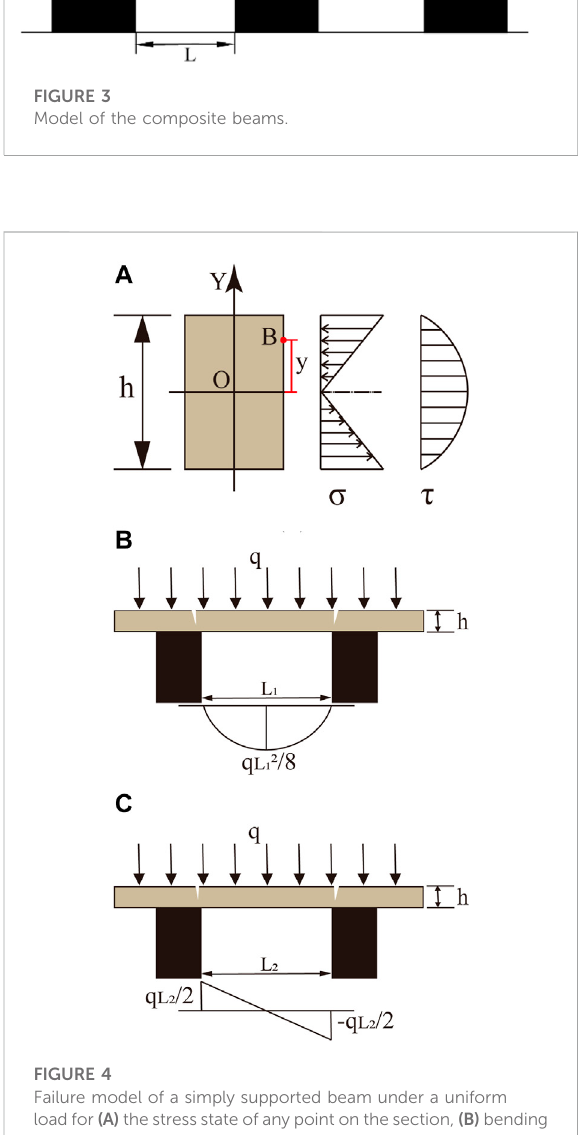
FIGURE 4 Failure model of a simply supported beam under a uniform load for (A) thestress state of any point on thesection, (B) bending failure, and (C) shear